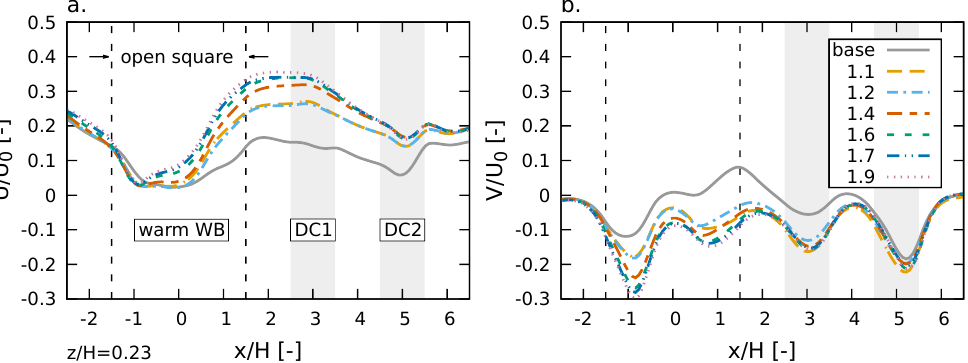
Figure 16. Profiles of ( a ) normalised streamwise ( U / U 0 ) and ( b ) normalised spanwise ( V / U 0 ) velocity over a horizontal line in the middle of the street canyon ( y / H = 1) at pedestrian level ( z / H = 0.23) for the warm water body cases ( ∆ T = + 2 K) and different water body shapes. The shaded areas denote the position of the downwind canyons DC1 and DC2. The location of the open square is shown with the vertical dotted